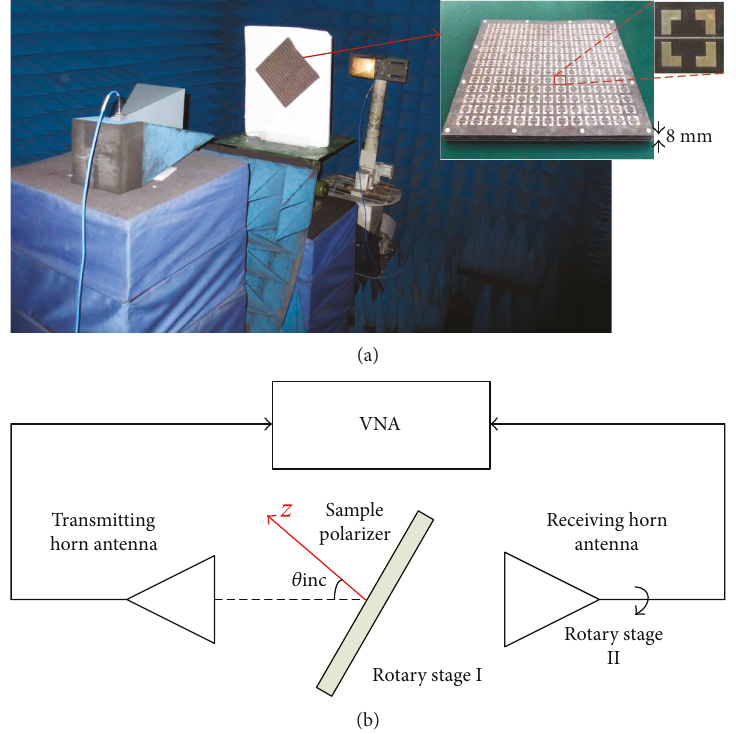
: Transmission coe ffi cient and phase di ff 2